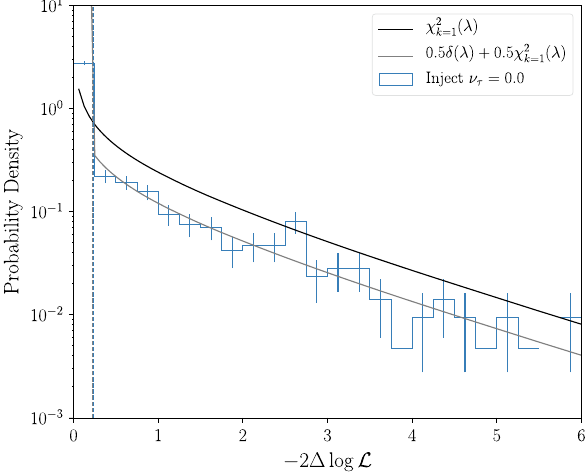
Fig. 8 Test statistic distribution of the one-dimensional pseudo Monte Carlo trials for an injected vanishing astrophysical tau neutrino flux. The expected half- χ 2 distribution (gray line) is followed. The χ 2 k = 1 k = 1 distribution is shown for reference (black line). The vertical lines that mark the events contributing to the 68% confidence interval (blue), and the expectation from the half- χ 2 distribution (gray) are almost k = 1 perfectly